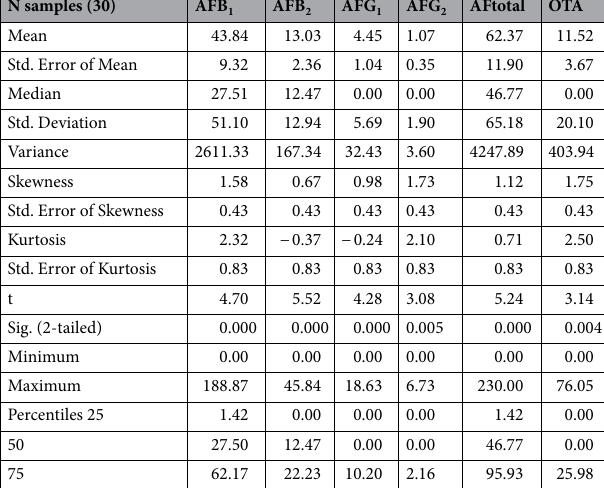
Table 7. Statistical summary of data obtained from the Ashanti Region of Ghana.